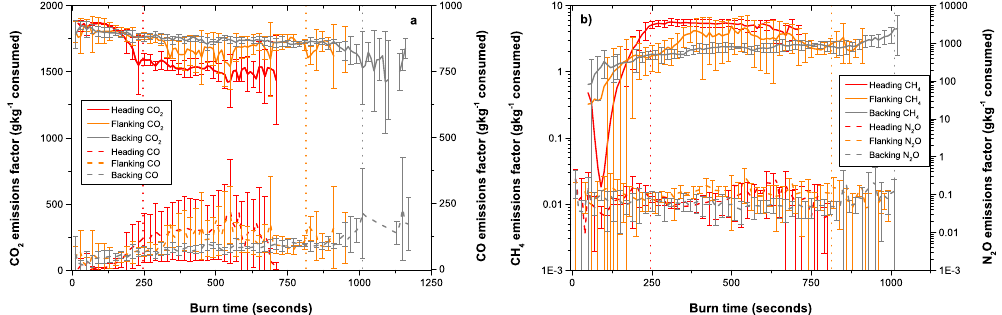
Figure 9. Time-resolved emissions factors for the trace gas emissions species measured during the experimental burns. (a) Time-resolved CO 2 and CO emissions factors. (b) Time-resolved CH 4 and N 2 O emissions factors. Coloured vertical and dotted bars represent the median end time for predominantly flaming combustion for each fire spread